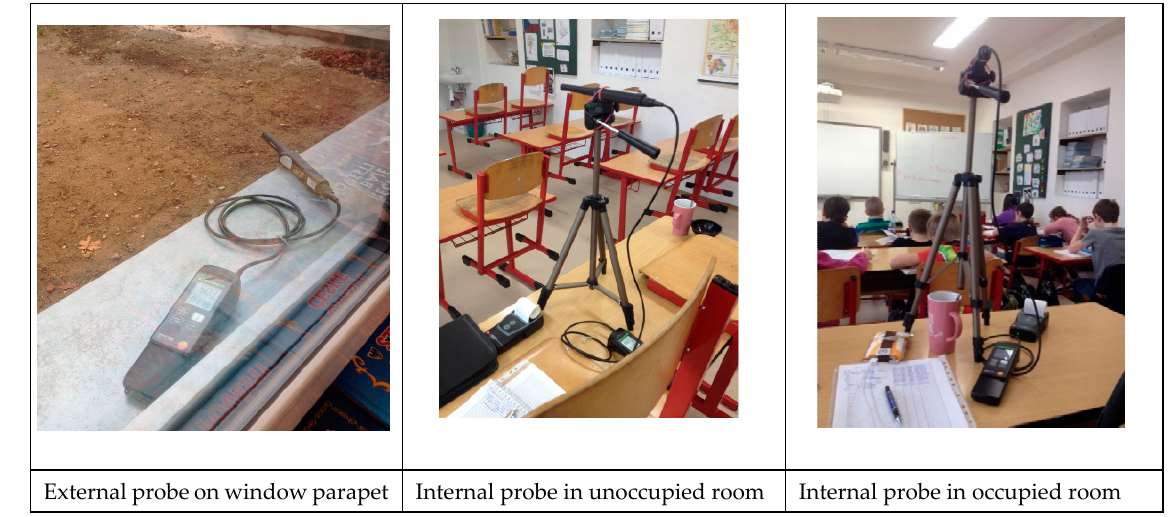
Figure 4. Set for measurement of CO 2 concentration in the classroom.